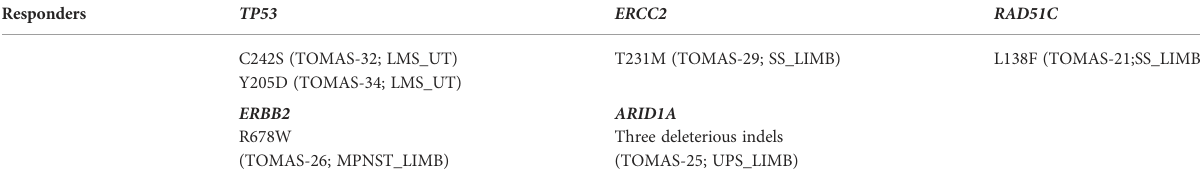
UT, uterus; RP, retroperitoneum.